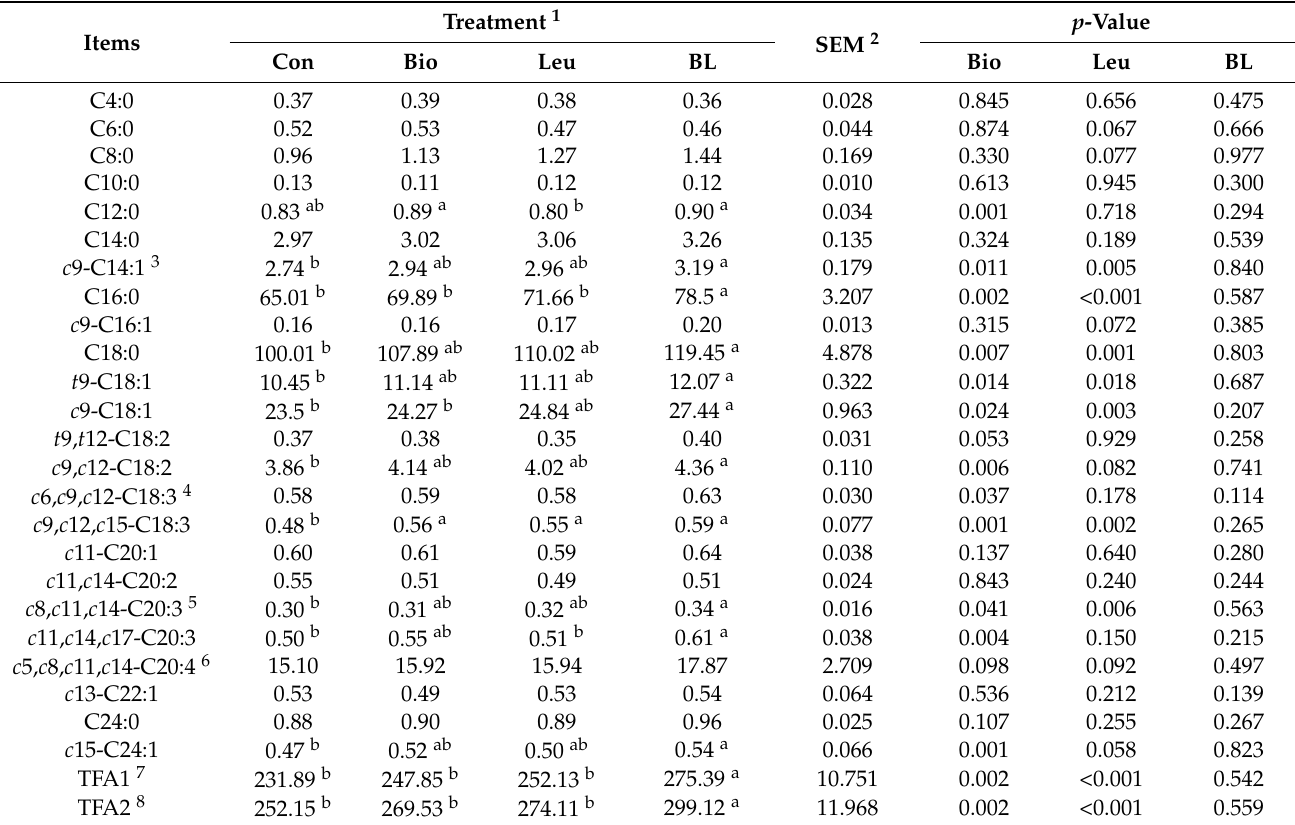
Table 3. Effects of biotin and leucine supplementation on fatty acid concentrations in vitro ( µ